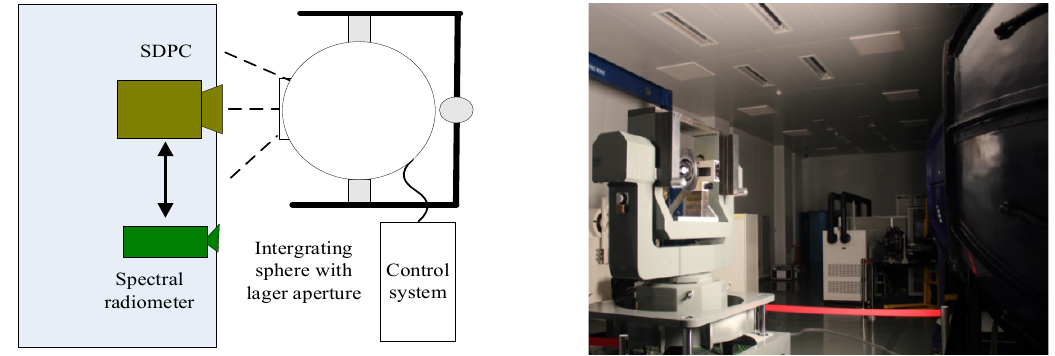
Figure 6. The schematics of NURP measurement system(left) and the real object of it (right) Fig. 7 shows measurement results of NURP in SDPC’s bone image is clearly distinguishable, which is inherent 490nm P3 channel at test position matrix 7×7 (left) and feature of the CCD detector. The maximum difference 15×15 (right). Obviously, NURP produced measurement between bone image and fringe areas is about 0.7%. In error. In the Fig. 7 (left), the relative deviation of order to correct the NURP, we analyze it in the relative response in the sectional splice gap is about 0.5%. In the transmittance of low frequency and the Fig. 7 (right), there is no sectional splice gap, but the